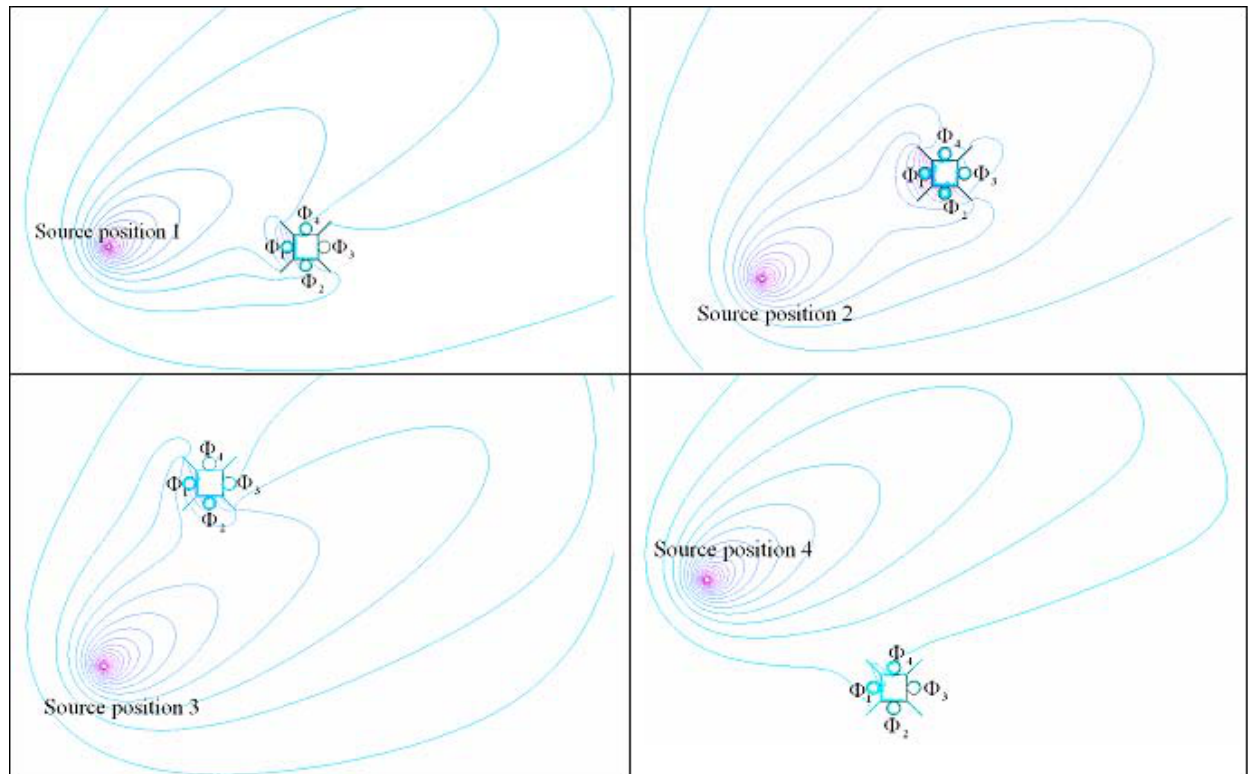
Figure 9. Contour plot of concentration at